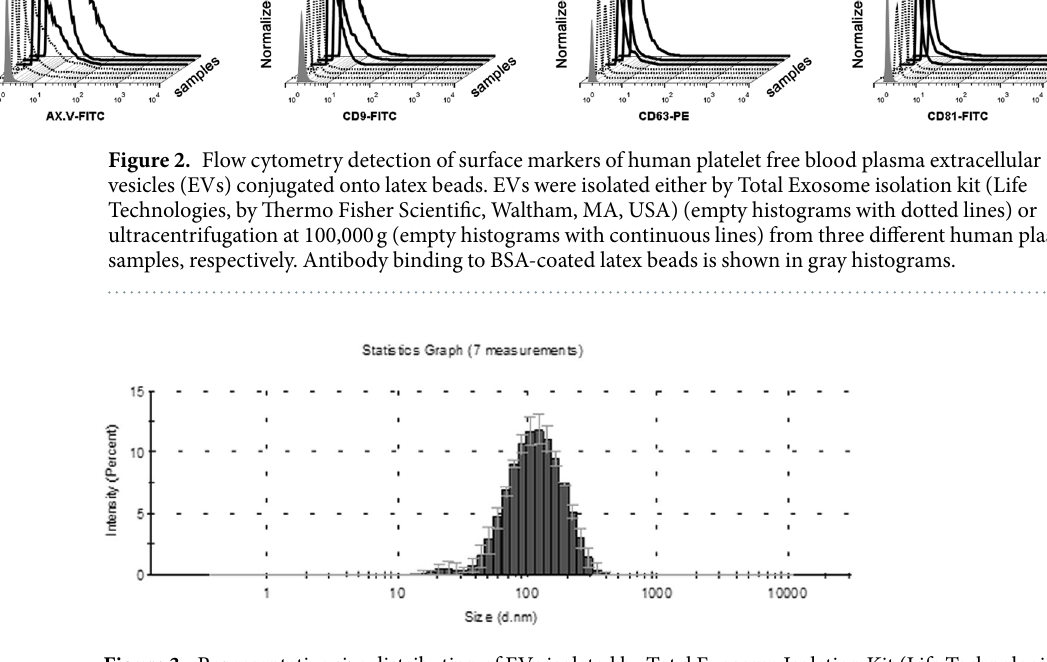
Figure 3. Representative size distribution of EVs isolated by Total Exosome Isolation Kit (Life Technologies, by Thermo Fisher Scientific) in sample 4 (Table 1). The y axis shows the intensity percentage of the vesicles, and the x axis shows the vesicle diameter (nm). The sizes of the EVs were approximately in the range of 16–255 nm (diameter [mean ± SD], 90.08 ±